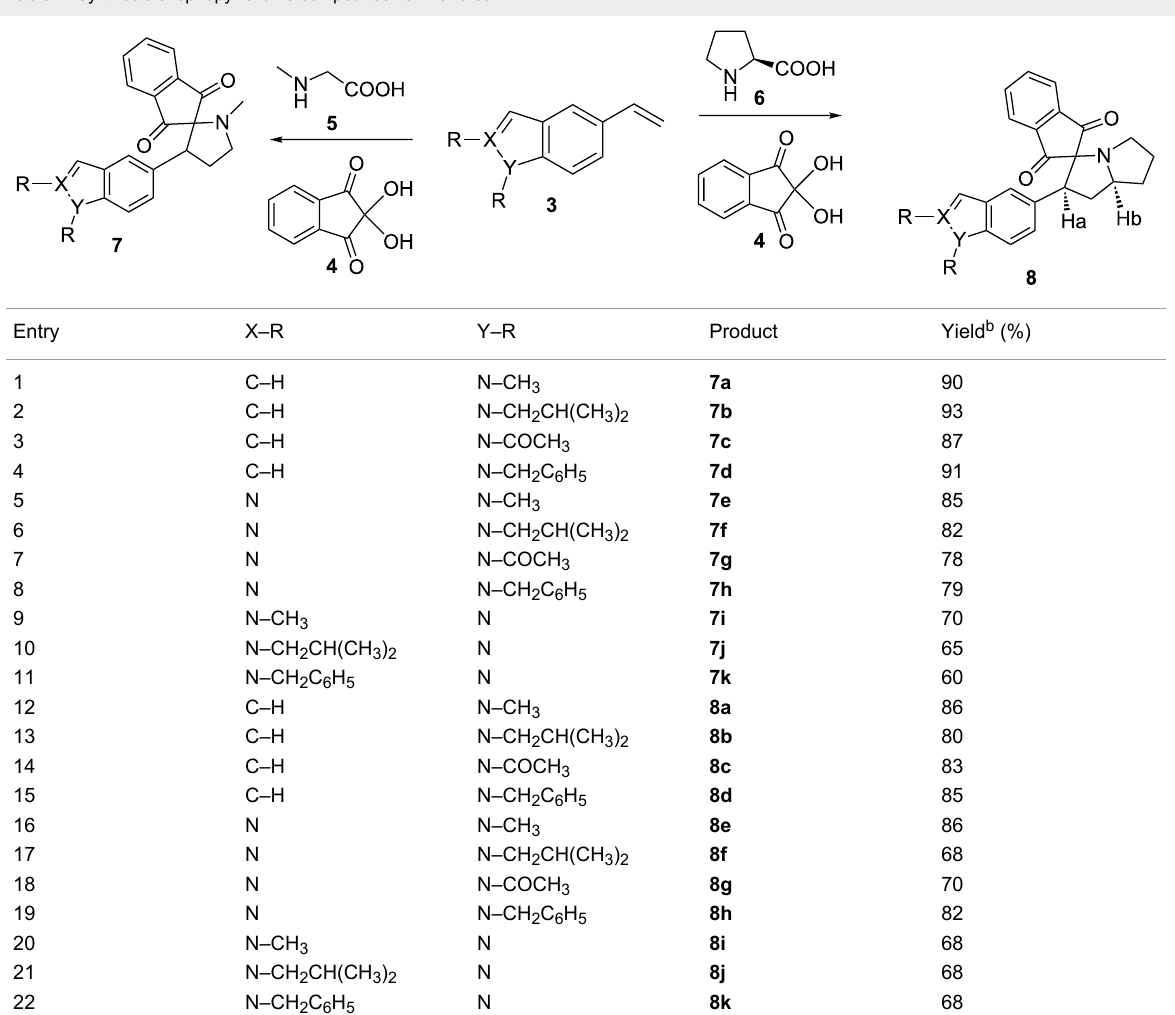
Table 1: Synthesis of spiropyrrolidine compounds 7a–k and 8a–k . a